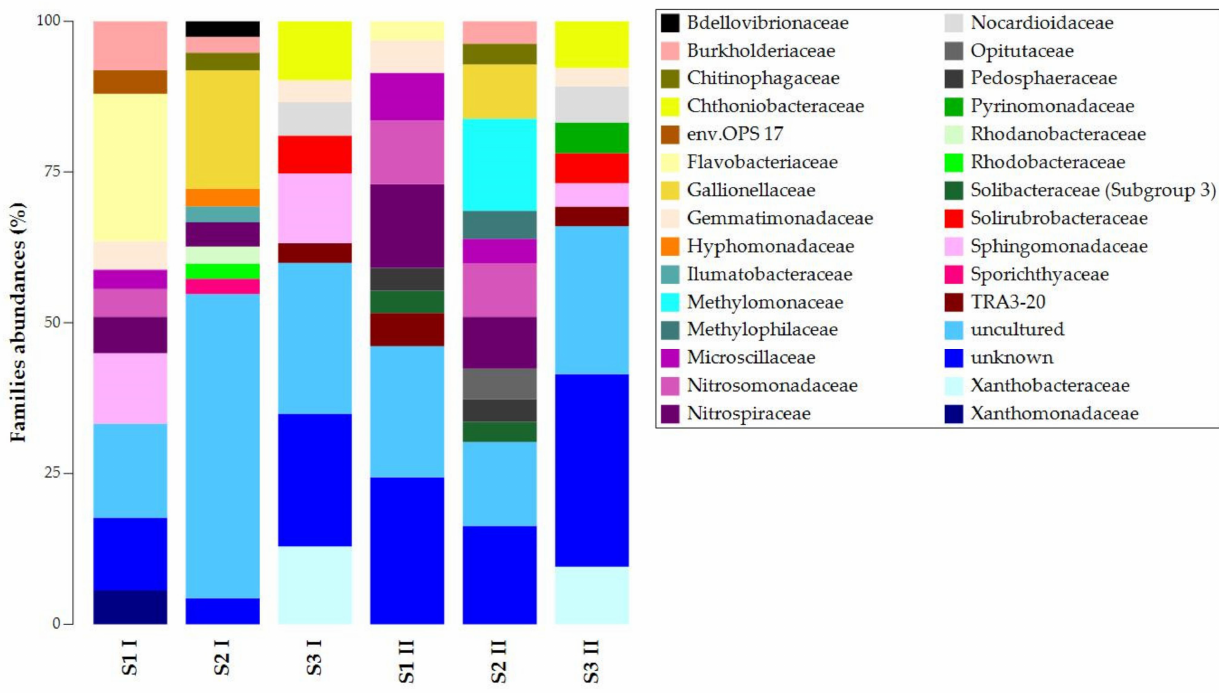
Figure 3. Taxonomy bar plot of ASVs at the family